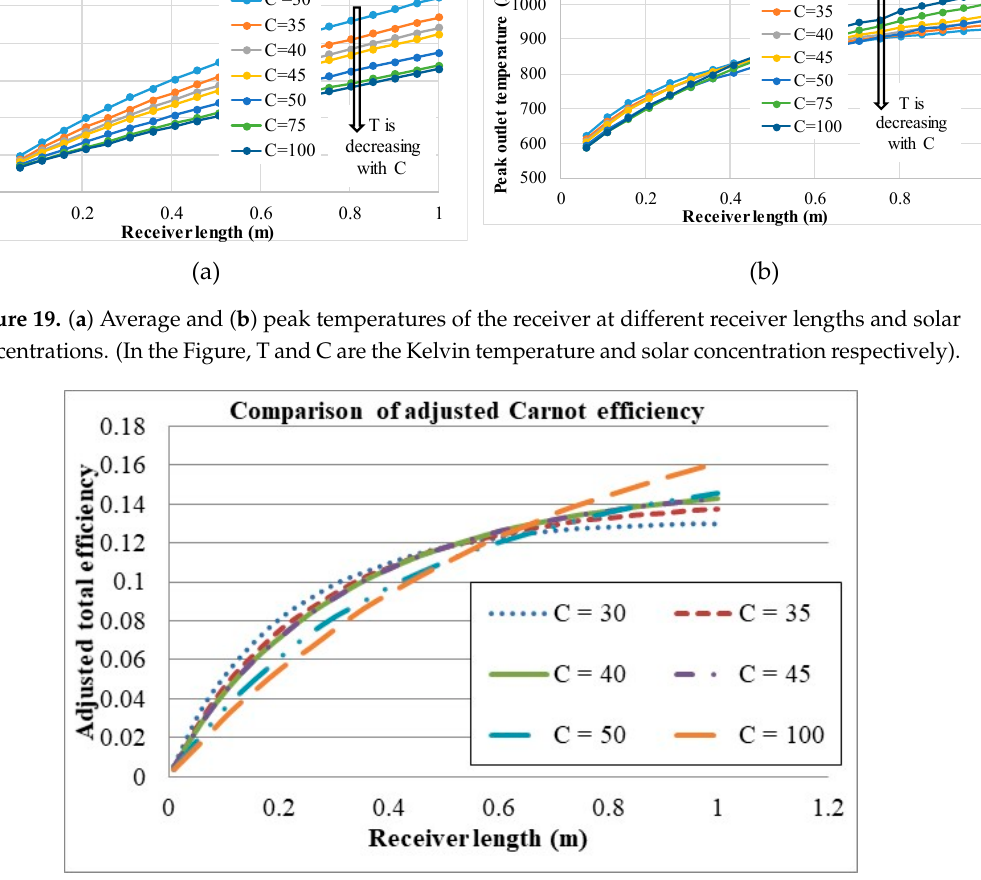
Figure 20. Comparison of solar concentration using adjusted Carnot efficiency.